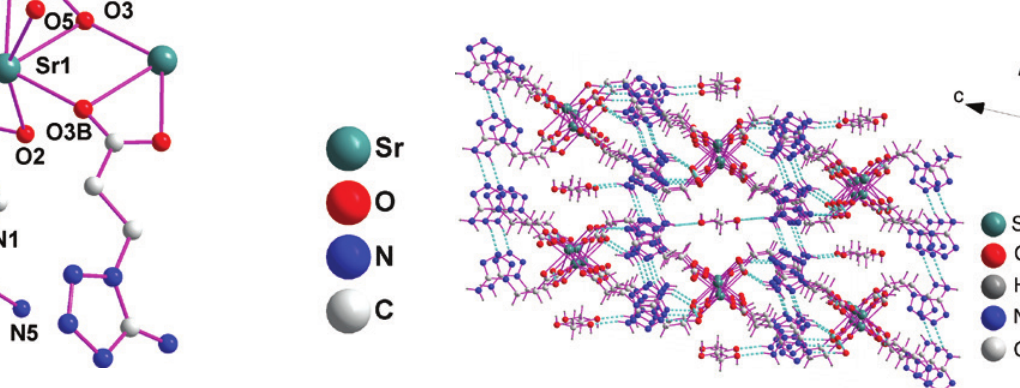
Figure 3: View of 1 , showing hydrogen-bonding interactions.